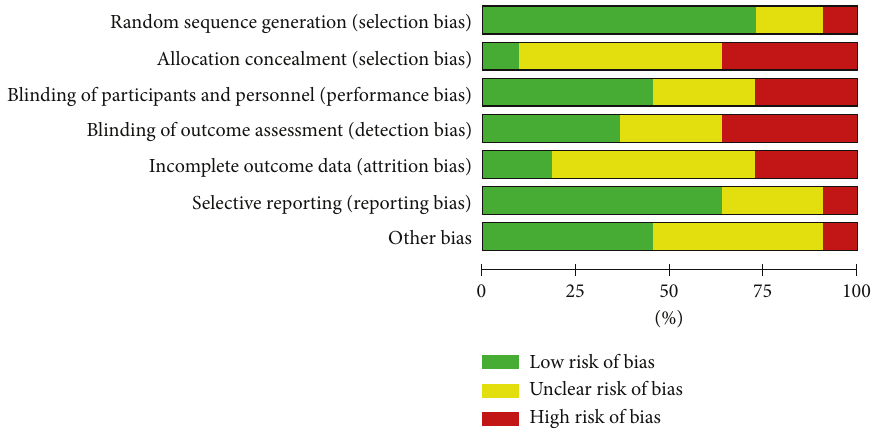
Figure 3: Risk of bias